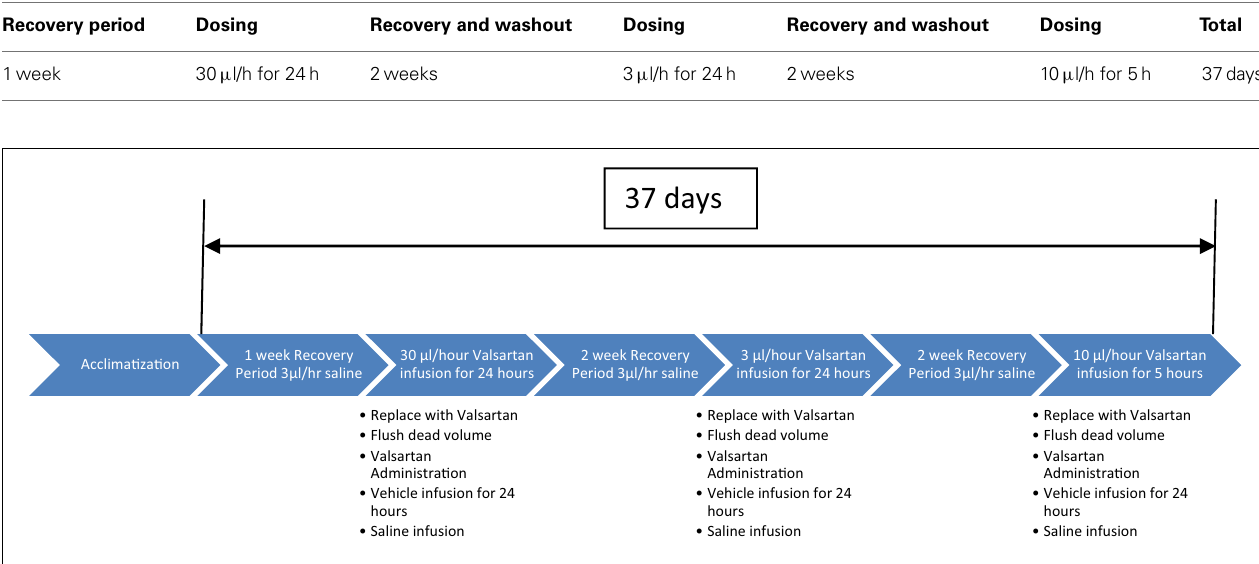
Table 4 | Brief summary of study protocol.